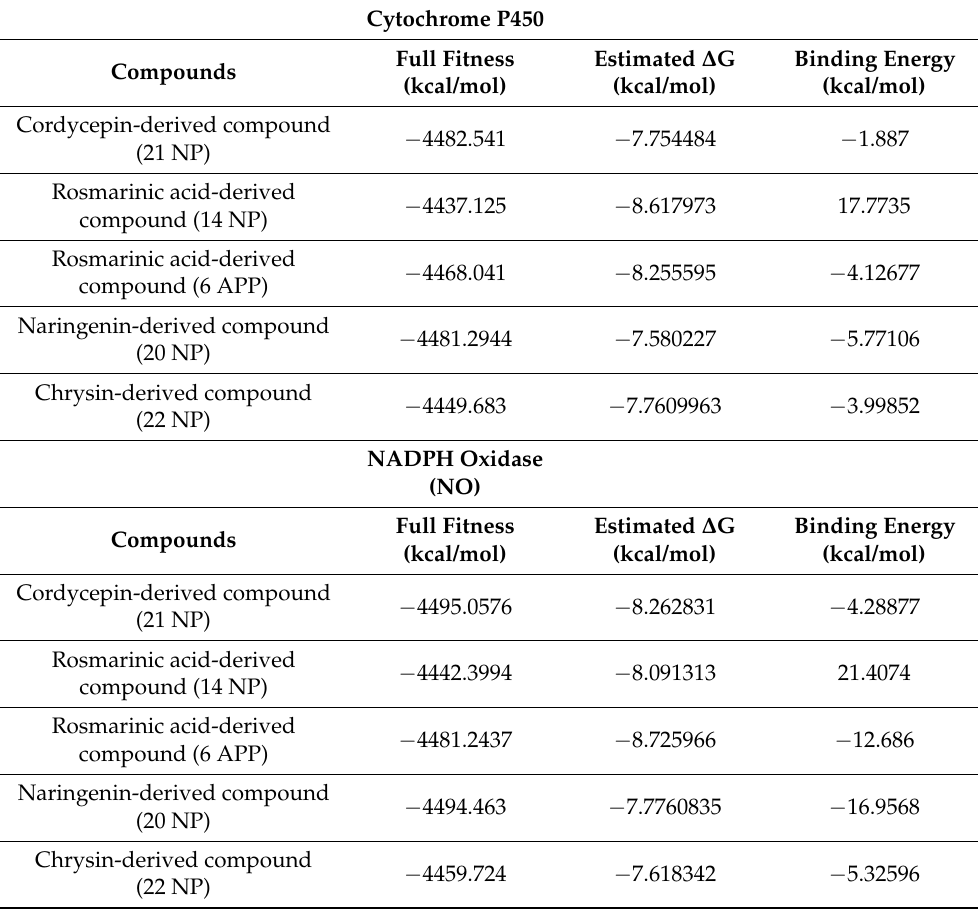
Figure 4. Selected compounds with more conformational stability and biological activity on MAO- B. ( A ) Cordycepin-derived compound (21 NP); ( B ) rosmarinic acid-derived compound (14 NP); ( C ) rosmarinic acid-derived compound (6 PP); ( D ) naringenin-derived compound (20 NP) and ( E ) chrysin derived compound (22 NP). Table 2. Compound docking test of selected compounds with higher activity against P450 cytochrome and NO